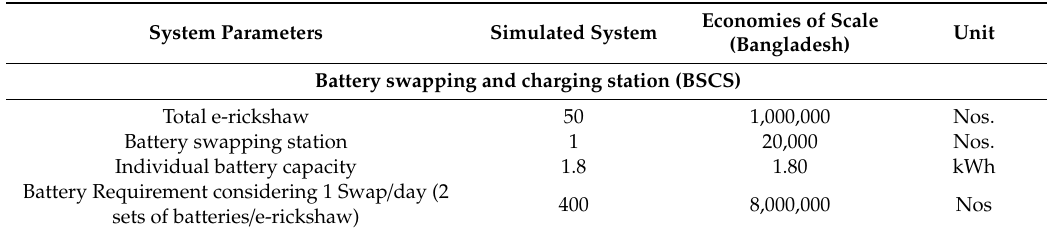
Table 4. Economies of scale of the simulated system (linear).